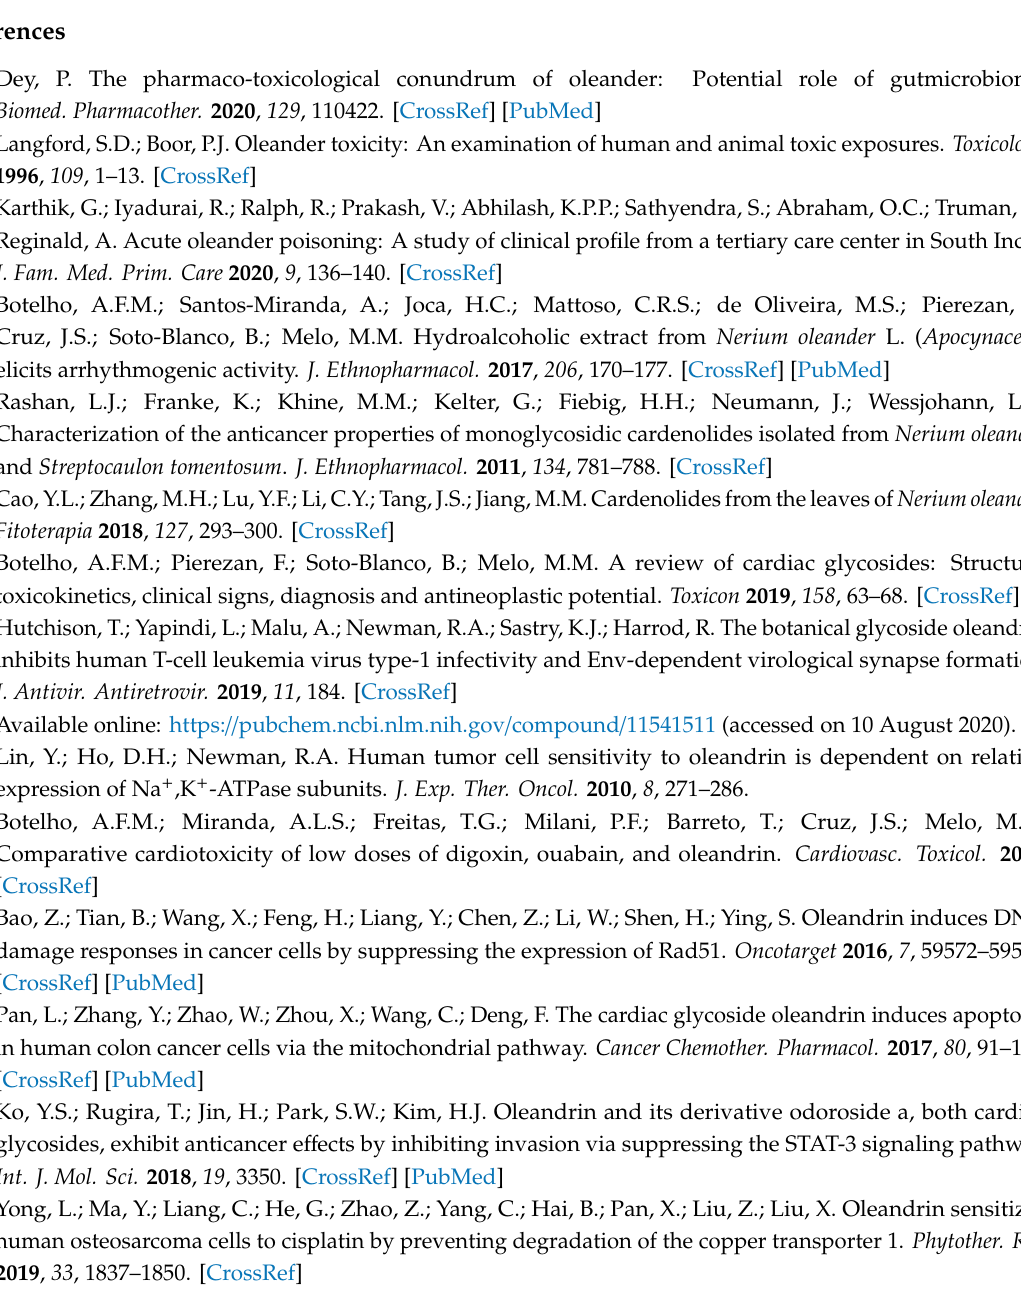
Supplementary Materials: The following are available online, Table S1: E ff ect of oleandrin on the growth of various single-gene knockout